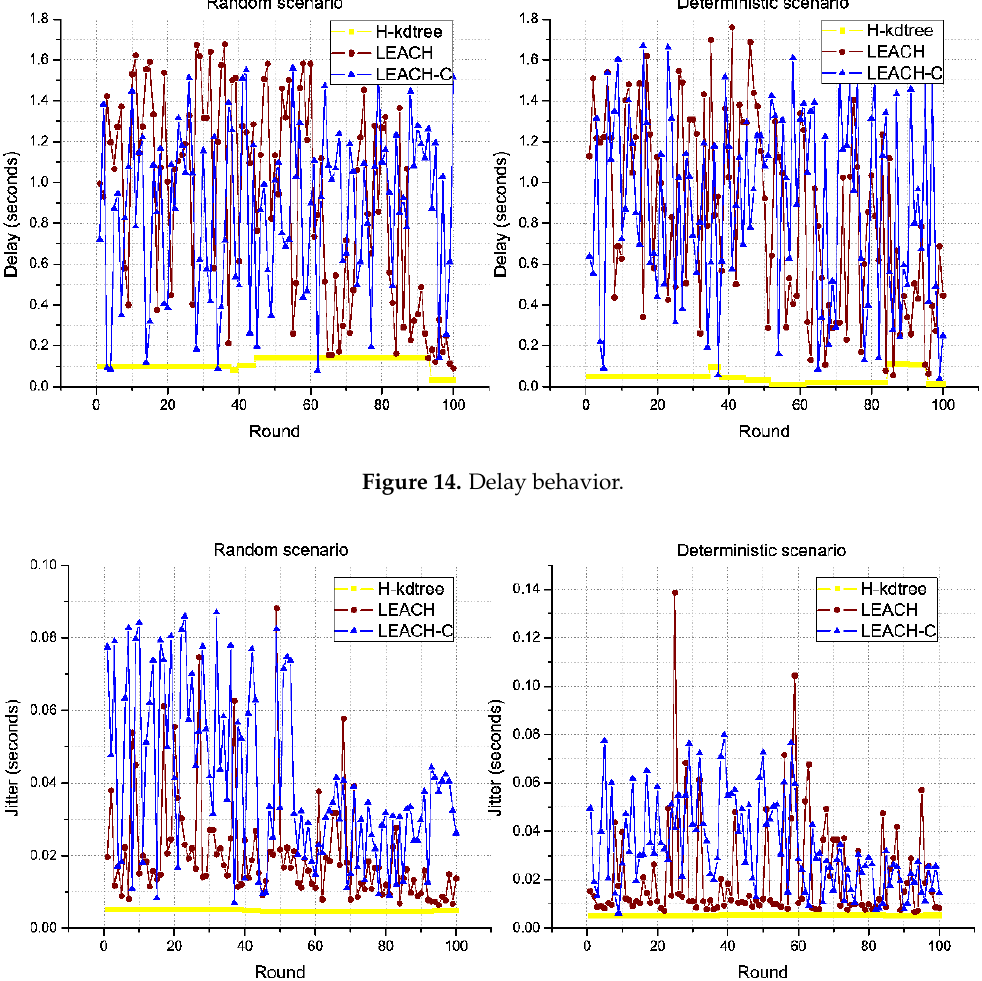
Figure 15. Jitter behavior.